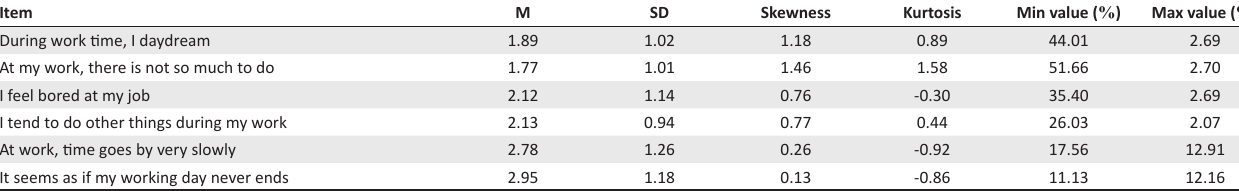
TABLE 1: Descriptive statistics for the items of the workplace boredom construct. Item